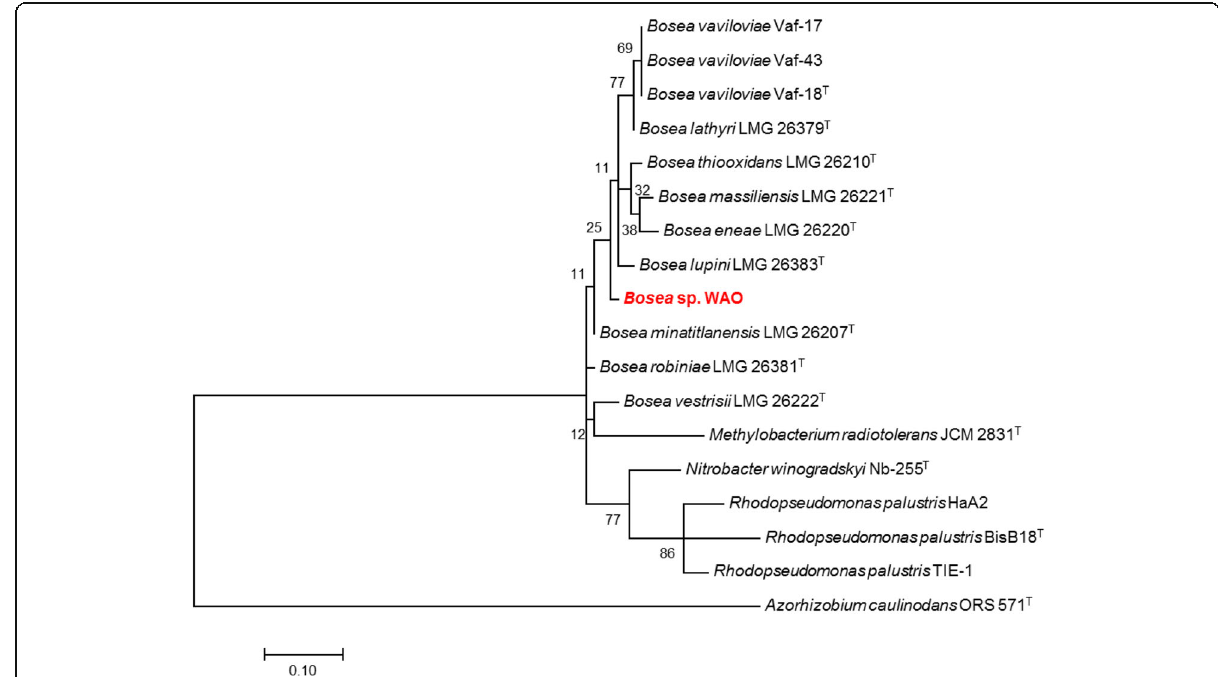
Fig. 4 Molecular Phylogenetic analysis by Maximum Likelihood method of the dnaK gene. The evolutionary history was inferred by using the Maximum Likelihood method based on the Tamura-Nei model [19]. The tree with the highest log likelihood ( − 613.9292) is shown. The percentage of trees in which the associated taxa clustered together is shown next to the branches. Initial tree(s) for the heuristic search were obtained automatically by applying Neighbor-Join and BioNJ algorithms to a matrix of pairwise distances estimated using the Maximum Composite Likelihood (MCL) approach, and then selecting the topology with superior log likelihood value. The tree is drawn to scale, with branch lengths measured in the number of substitutions per site. The analysis involved 18 nucleotide sequences. Codon positions included were 1st+2nd+3rd+Noncoding. All positions containing gaps and missing data were eliminated. There were a total of 103 positions in the final dataset. Evolutionary analyses were conducted in MEGA7 [20]. Type strains are indicated with a superscript